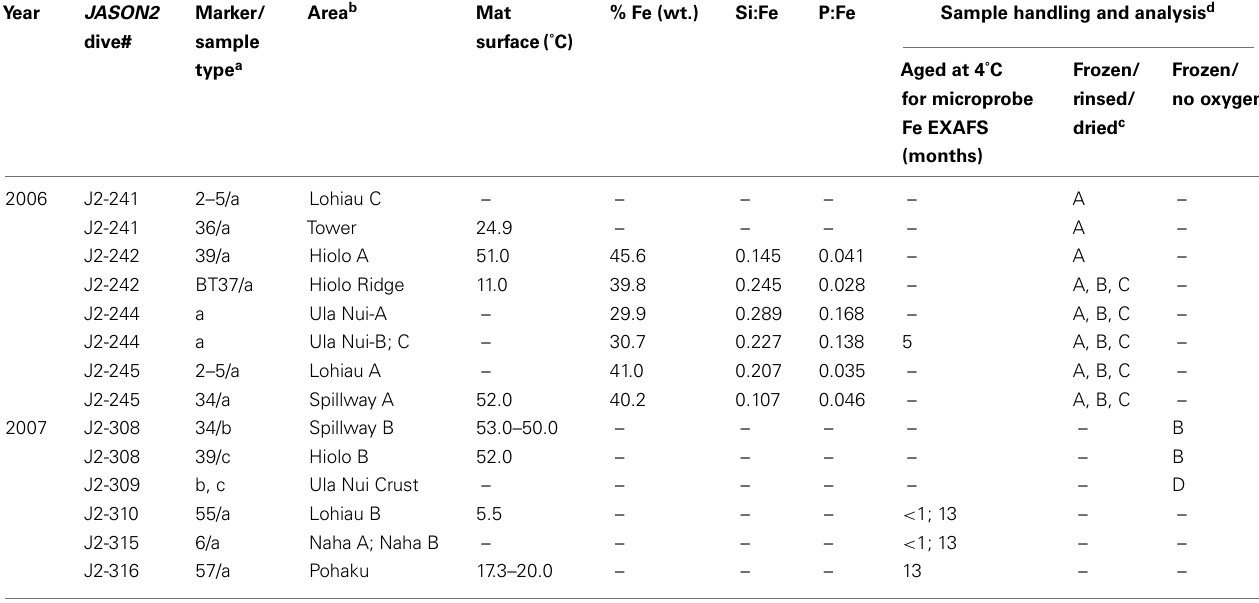
Table 2 | Summary of Loihi Seamount Fe mats examined. Solid-phase% Fe, and Si:Fe and P:Fe mole ratios reported with sample handling and analyses